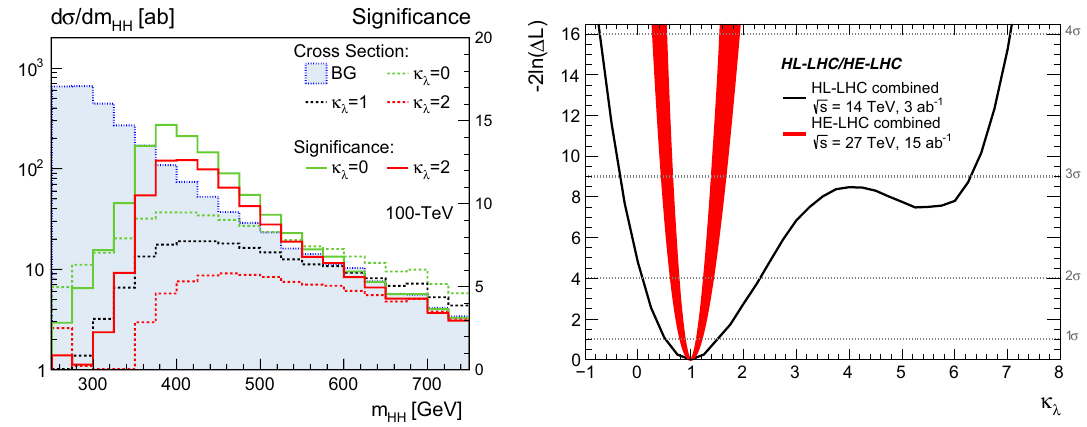
Fig. 10.6 Left: dependence on κ λ of the m HH spectrum [295]. Right: expected sensitivity for the measurement of the Higgs trilinear coupling in the gg → HH process at HE-LHC